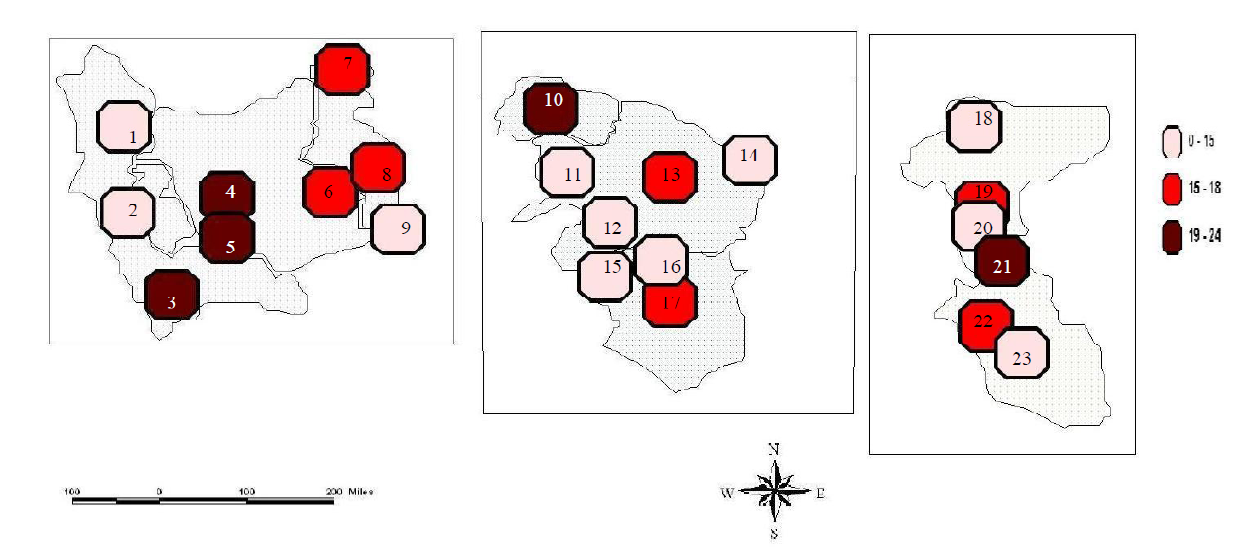
Fig. 2. Location rating based on temperature 1-Kooy; 2-Oroomieh; 3-Mahabad; 4-Tabriz; 5-Maragheh; 6-Sarab; 7-Parsabad; 8-Ardebil; 9-Khalkhal; 10-Bojnurd; 11-Sabzevar; 12-Kashmar; 13-Mashhad; 14-Sarakhs; 15-Ghaen; 16-Ferdous; 17-Birjand; 18-Kashan; 19-Isfahan; 20-Shargh Isfahan; 21-Abadeh; 22-Shiraz;